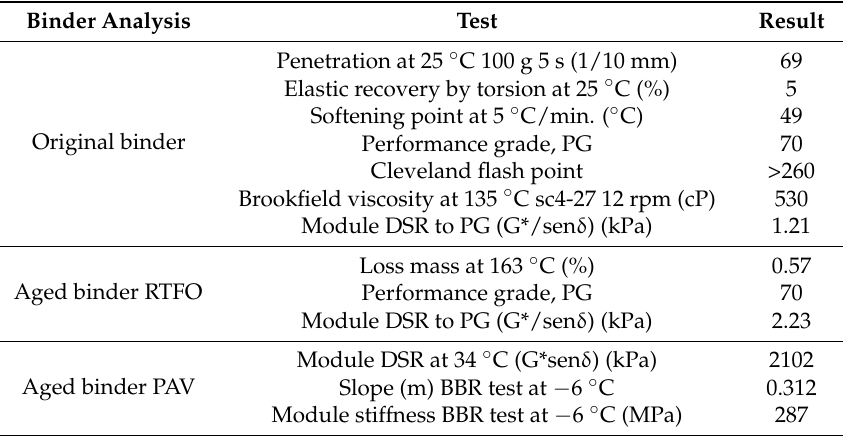
Table 3. Asphalt analysis.